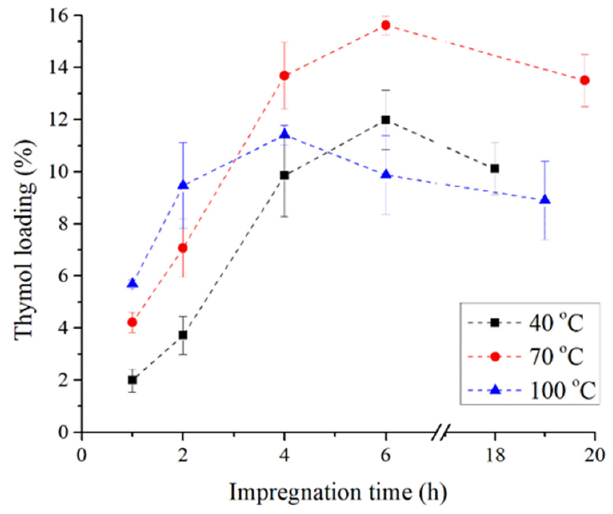
Figure 2. Kinetic of thymol loading into TPS–PCL.